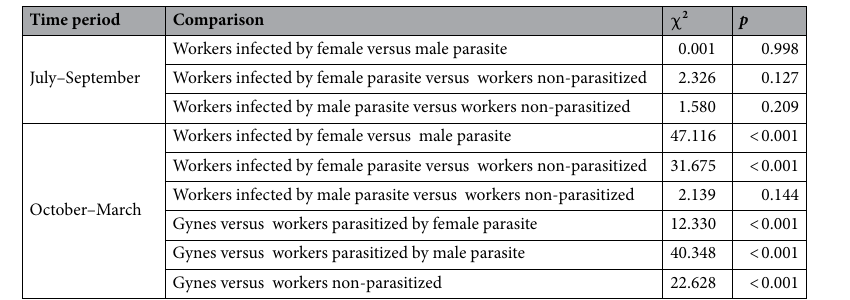
Table 2. Pairwise comparisons of survival rates between different categories of wasps.